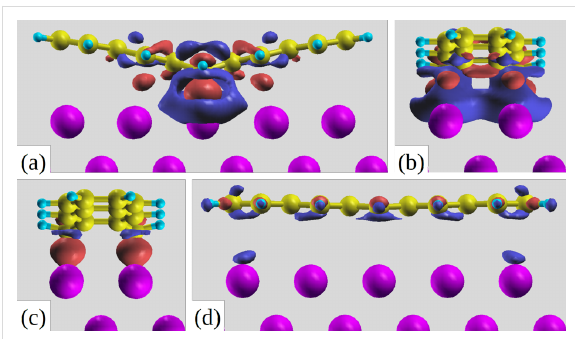
Figure 2: (a,b) Side views of the isodensity plot showing the bond charge of pentacene at the B-site for an isodensity = 0.002 e /Bohr 3 (red regions: high electron density and blue regions: low electron density), (c) pentacene at the B-site for an isodensity of 0.005 e /Bohr 3 , (d) pentacene at the T-site for an isodensity of 0.001 e /Bohr 3 . Figure 3: Comparison between the Kohn–Sham eigenvalues of the